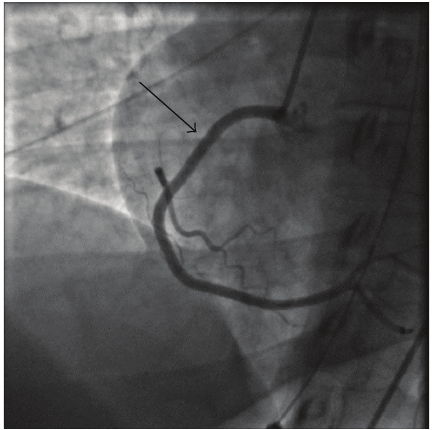
Figure 1: Coronary angiogram was performed within few hours after onset of symptoms and it showed 70% stenosis in proximal RCA flow. The lesion was irregularly contoured and hazy, which was consistent with fibromuscular dysplasia leading to spontaneous coronary artery dissection.